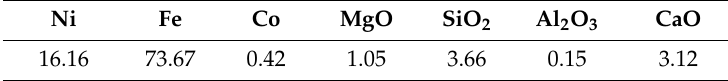
Table 5. Average main element analysis of ferronickel concentrate (wt